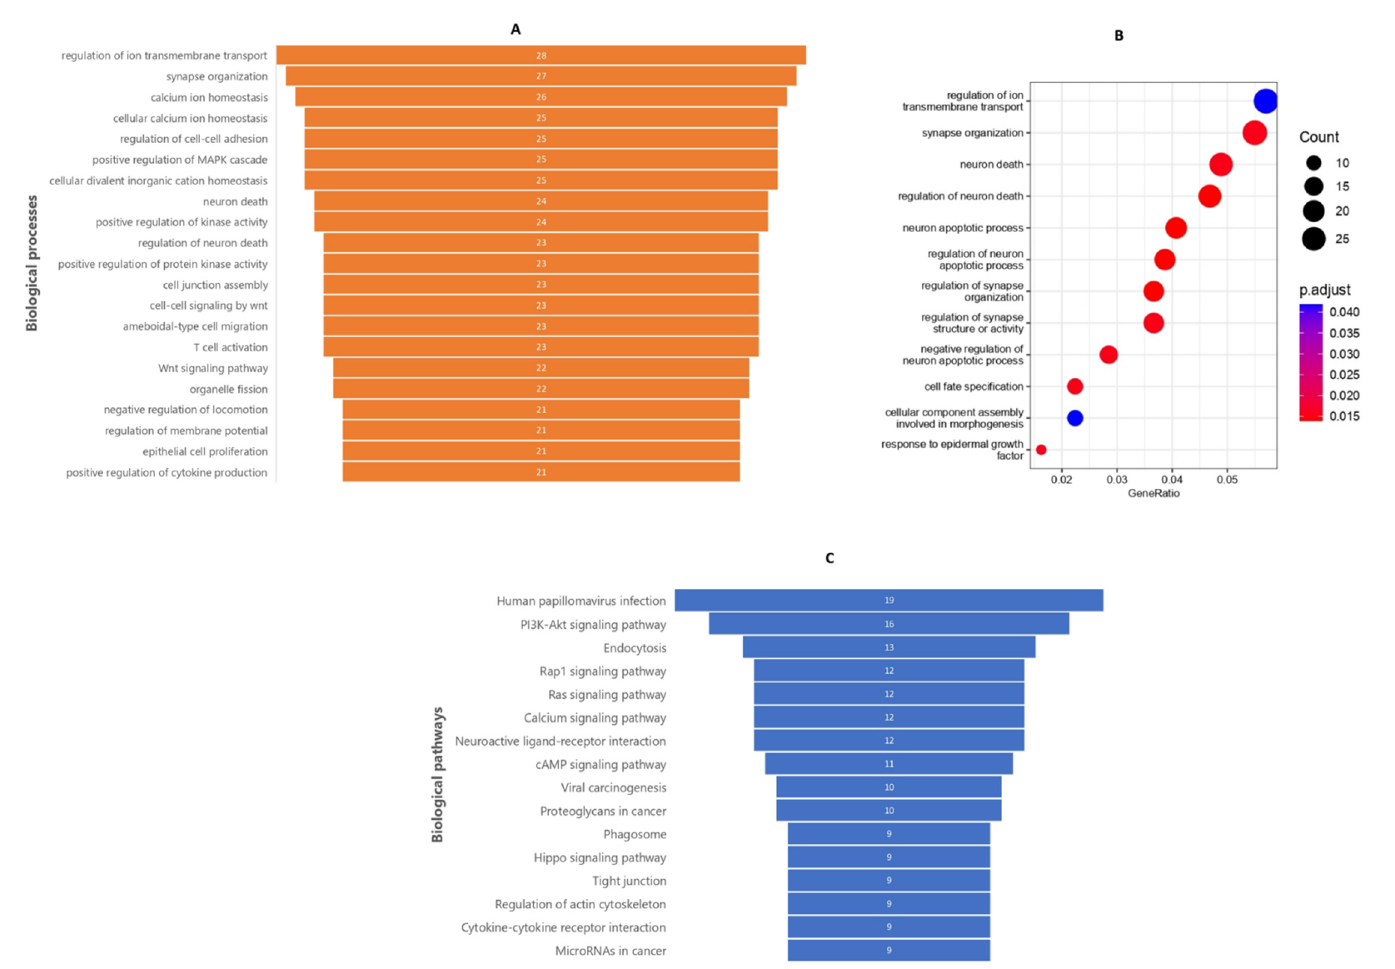
Figure 2. Gene ontology (GO-BP) and KEGG pathway analysis enrichment of genes associated with DMCs. ( A ) List of biological processes based on the DMC count after GO-BP analysis. ( B ) List of significant biological processes associated with DMC genes after GO-BP analysis. ( C ) List of biological pathways enriched for DMC-associated genes.